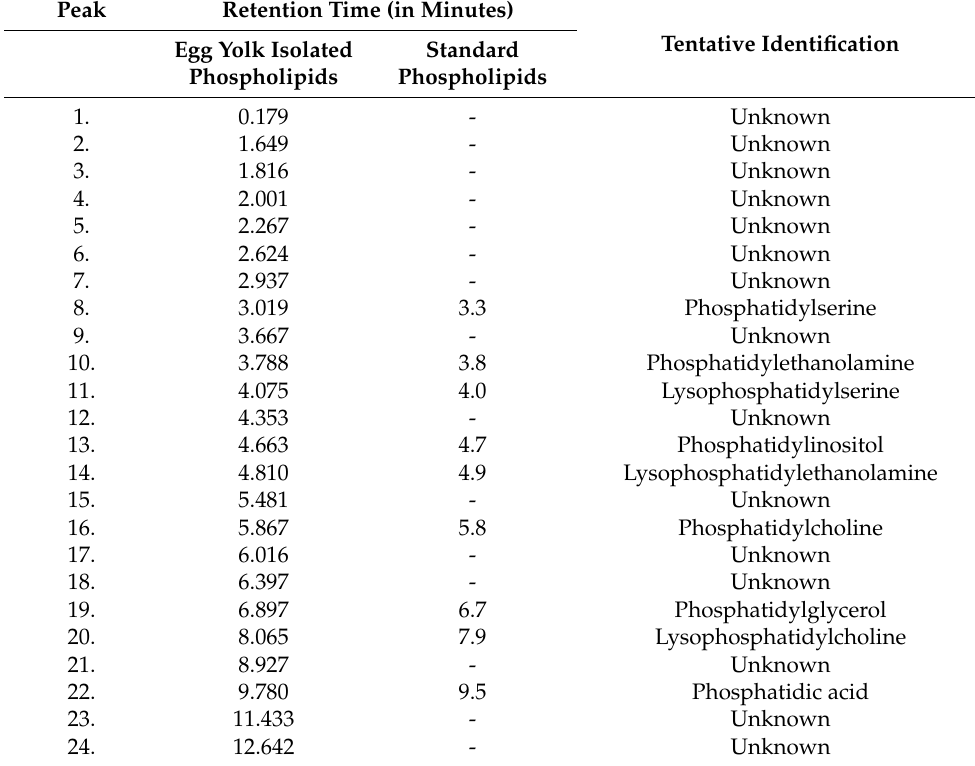
Table 2. Comparison of standard phospholipids with the egg yolk